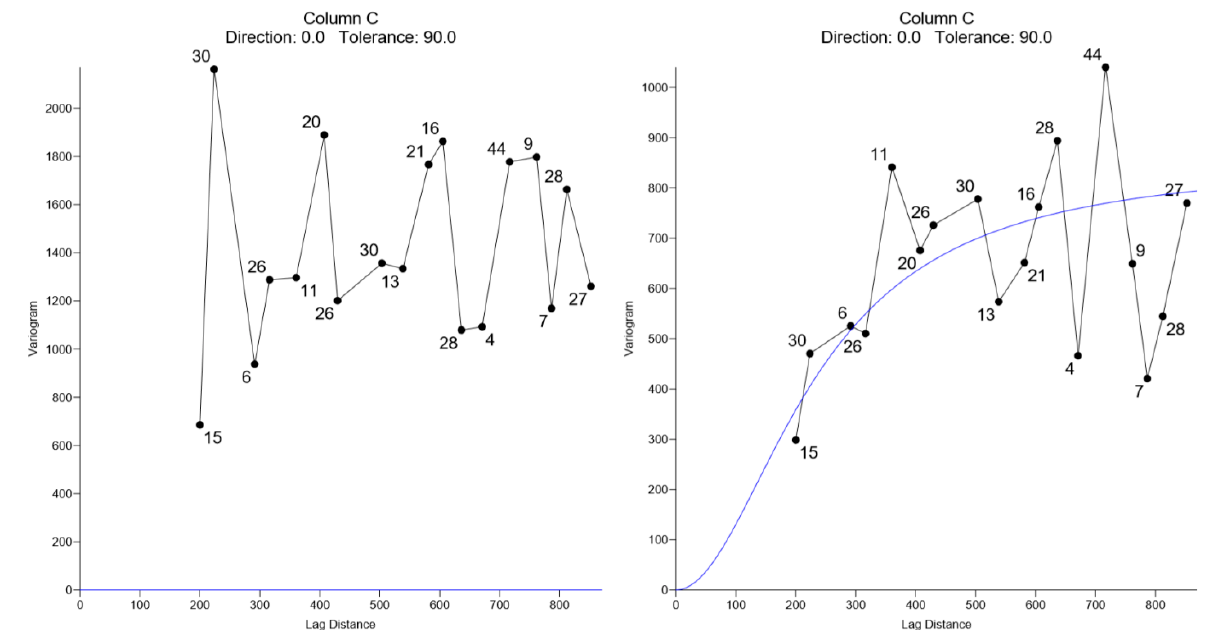
Figure 8. Semivariogram of Ni abundance [kg/m 2 ] in all studied horizons of the deposit ( left ) and in limonite ( right ). Numbers next to curve nodes indicate number of pairs for which the given quantity was calculated.